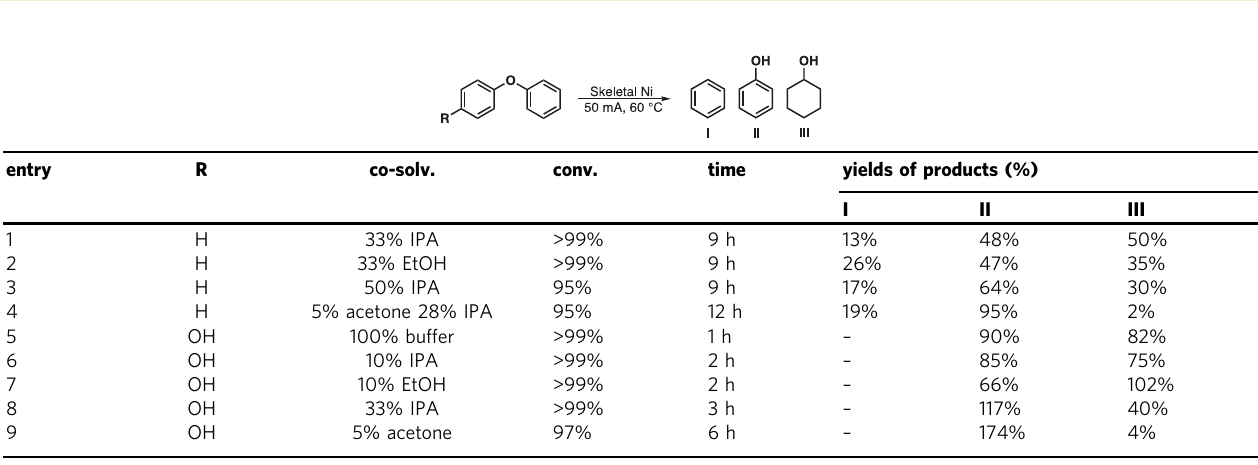
entry R co-solv.